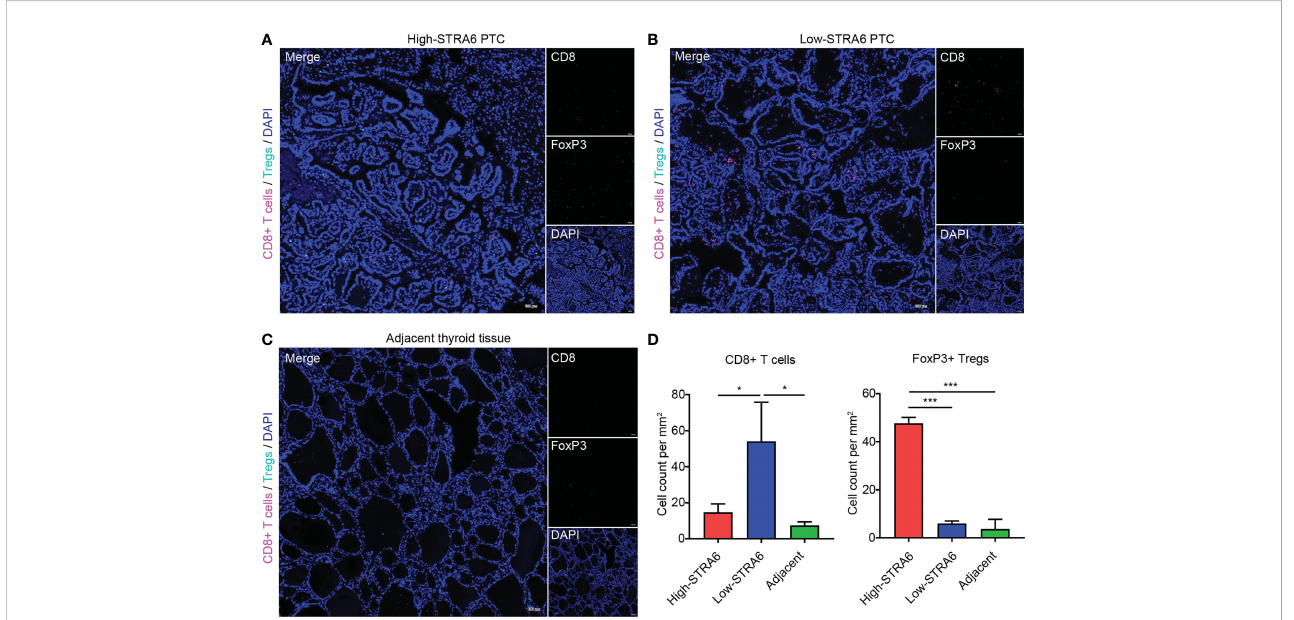
FIGURE 5 STRA6 increases Tregs abundance and inhibits CD8+ T cells in fi ltration in PTC. (A – C) Representative images of fl uorescent multiplex immunohistochemistry (mIHC) in high-STRA6 PTC, low-STRA6 PTC and adjacent thyroid tissue. CD8+ T cells were stained with CD8 a and Tregs were stained with FoxP3. Nuclei were stained with DAPI. (D) Positive Tregs and CD8+ T cells were counted in each group. (*p < 0.05, ***p < 0.001. The data are shown as the mean ± SD).